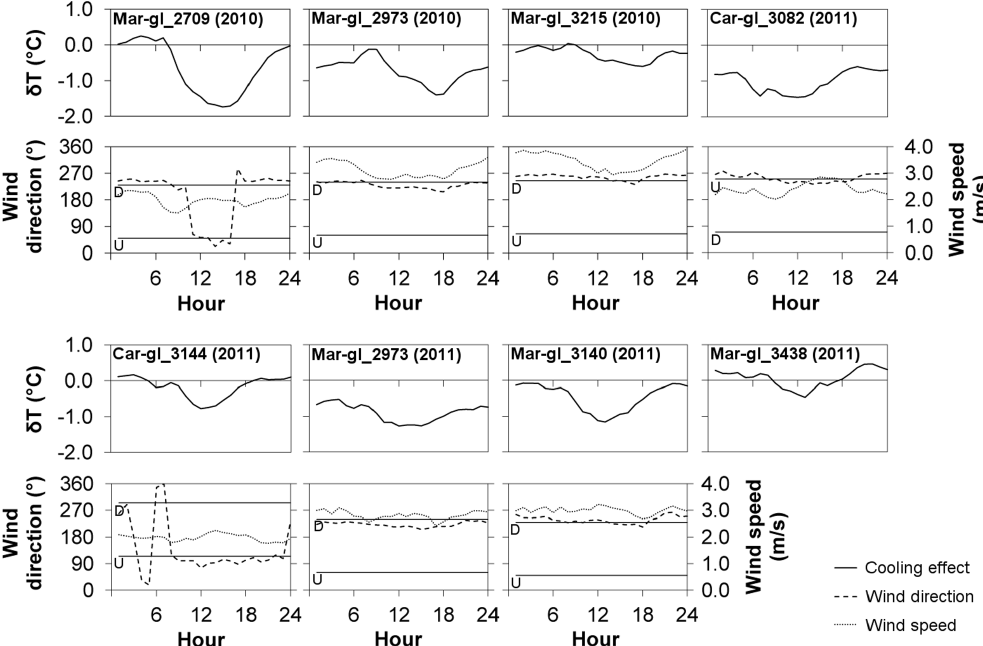
Figure 4. Mean daily cycle of the glacier cooling effect ( δT ), wind direction, and wind speed at the eight on-glacier weather stations. The operation period of each station is indicated in parentheses. Down-glacier and up-glacier wind directions are indicated with straight lines marked with “D” and “U”. Mar-gl_3438 lacks wind data because of anemometer